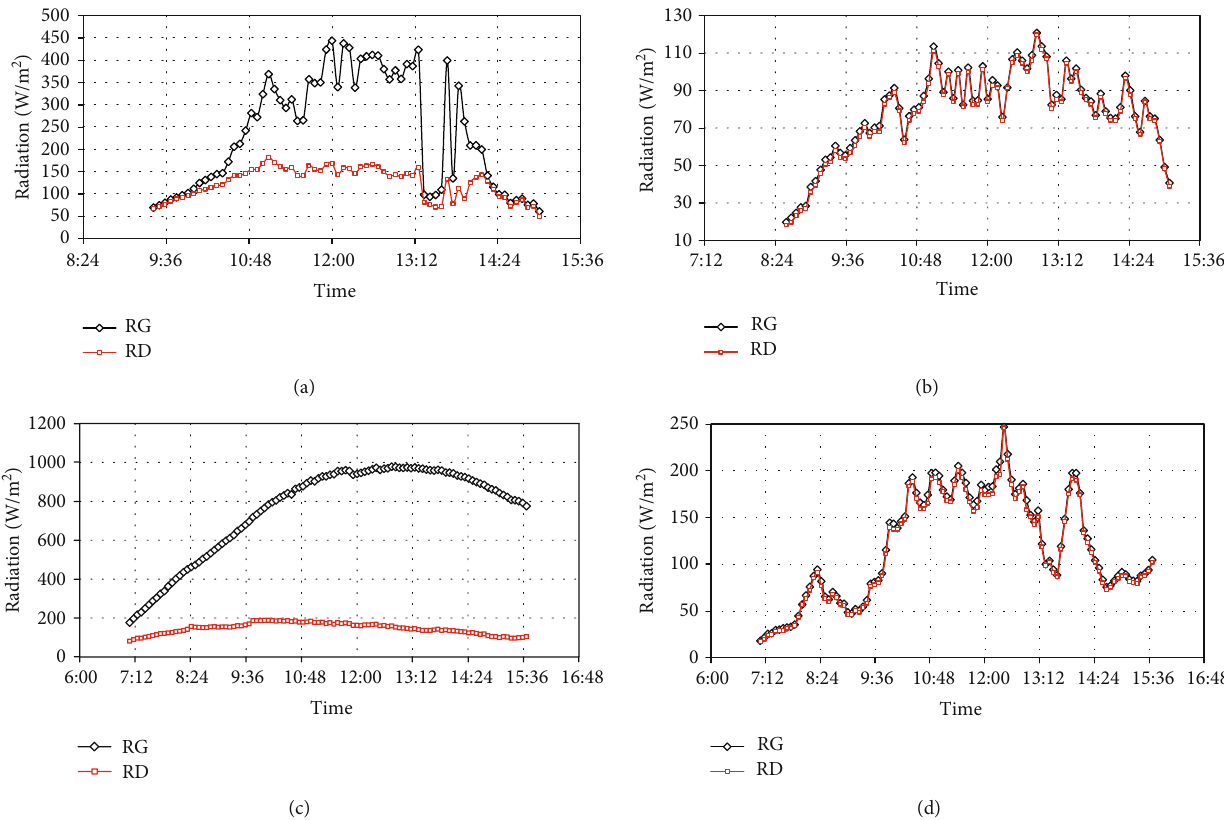
Figure 6: The solar global (RG) and di ff use radiation (RD): (a) winter clear day, (b) winter cloudy day, (c) summer clear day, and (d) summer cloudy day.